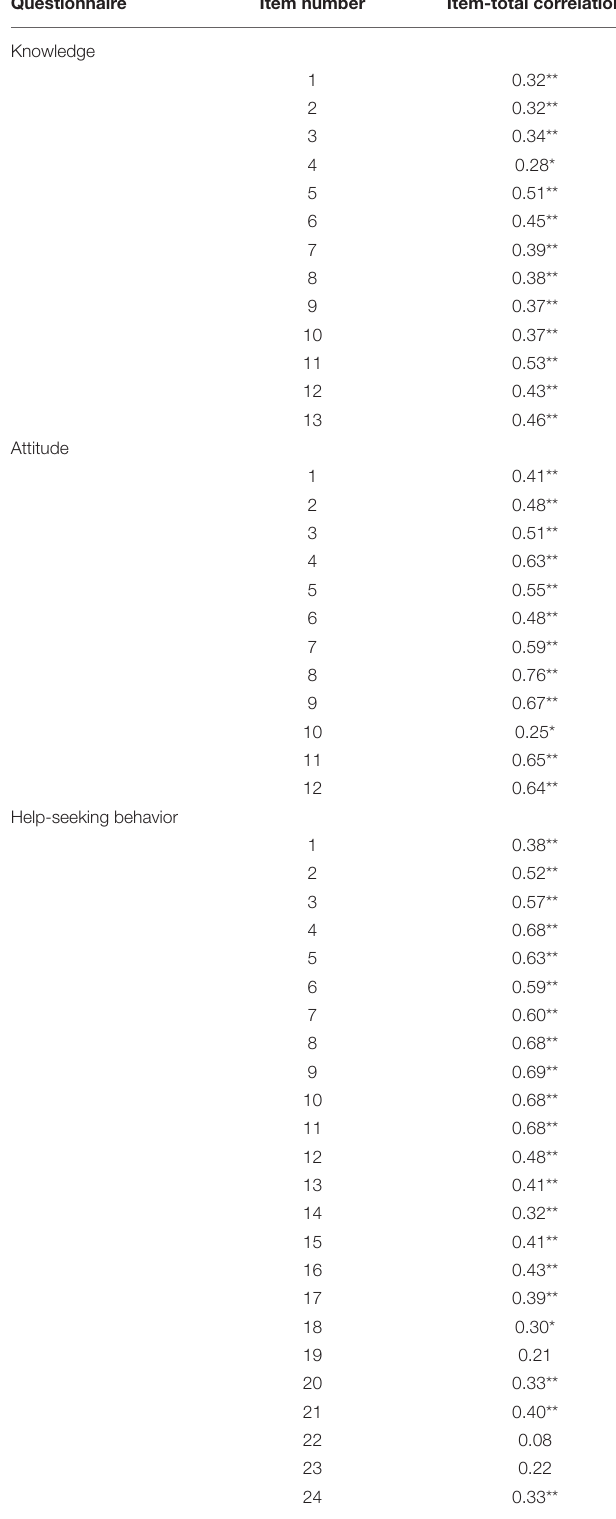
TABLE 3 | Item-total correlation coefficients for the Indonesian mental health literacy and help-seeking behavior set of questionnaires.